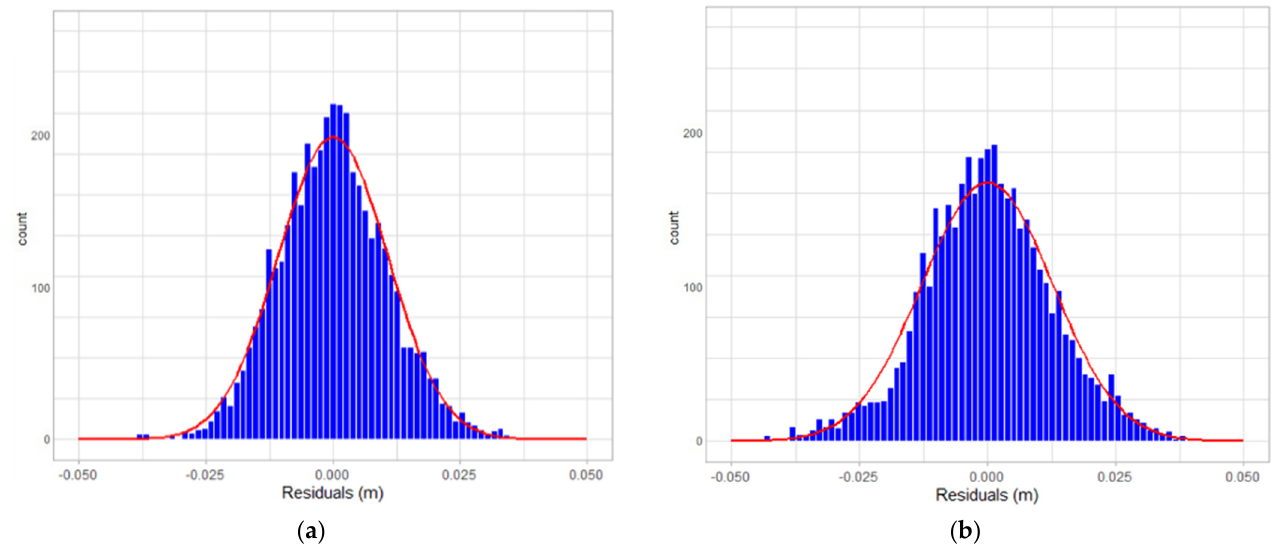
Figure 19. The residual distribution plots of dataset DATA1. ( a ) with Aps; ( b ) without Aps.